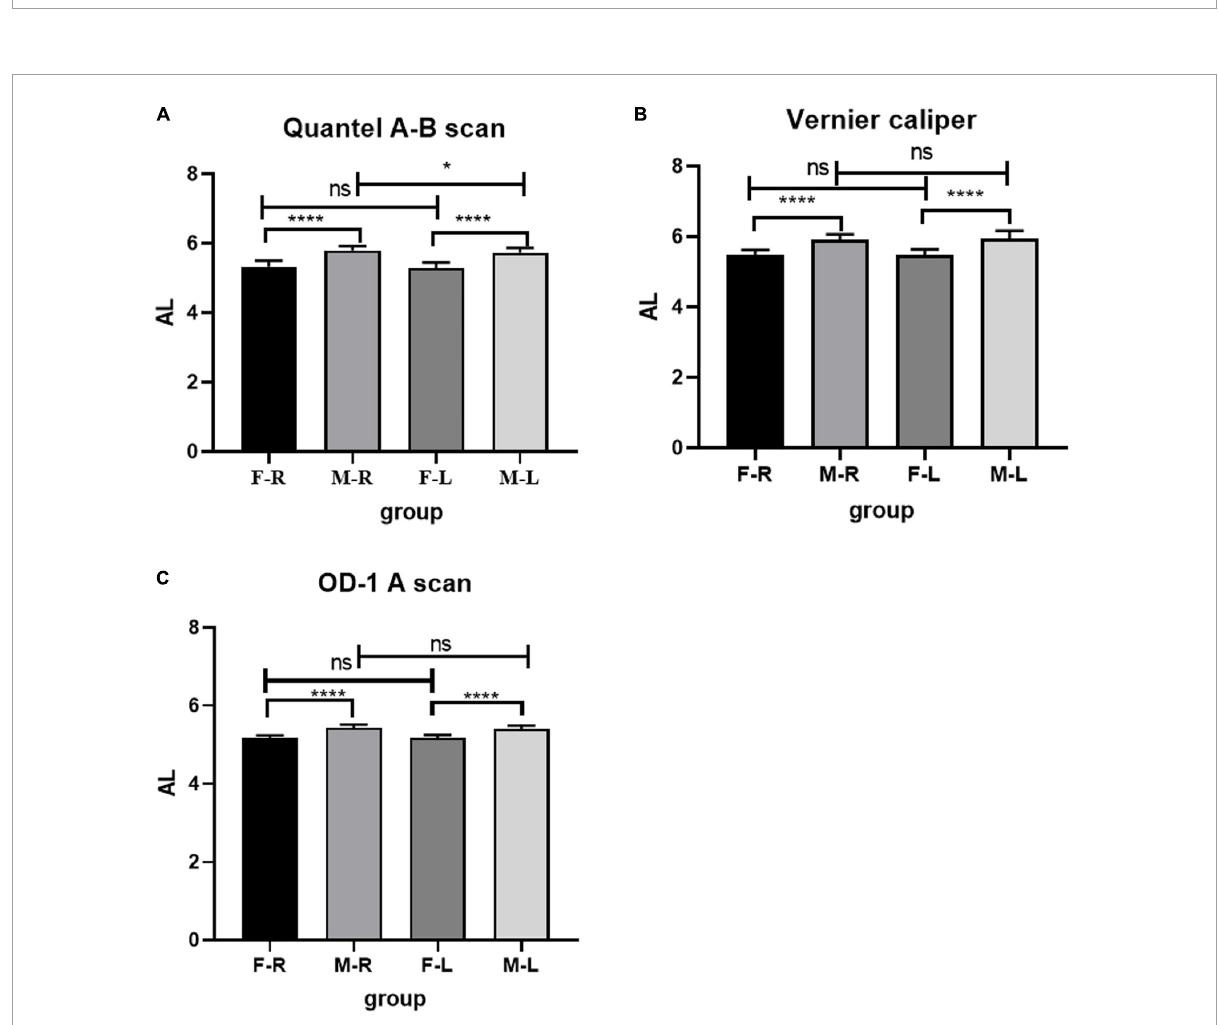
FIGURE2 Comparison of AL in Sprague Dawley (SD) rats of different sex and eye types. (A) AL results from Quantel A-B Scan. (B) AL results from Vernier caliper. (C) AL results from OD-1 A scan. F-R, female group right eye; M-R, male group right eye; F-L, female group left eye; M-L, male group left eye; AL, axial length; ns indicates no statistical significance; * p < 0.05; **** p <